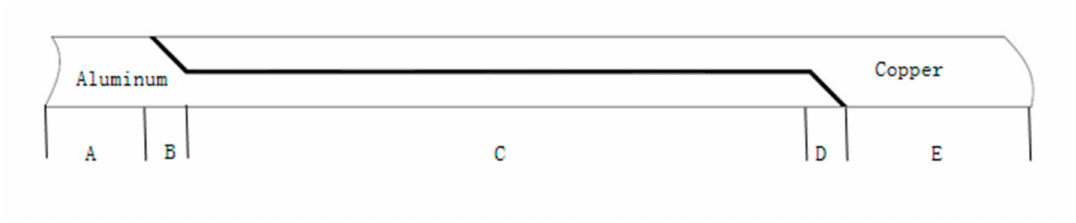
Figure 2. Five areas of lap